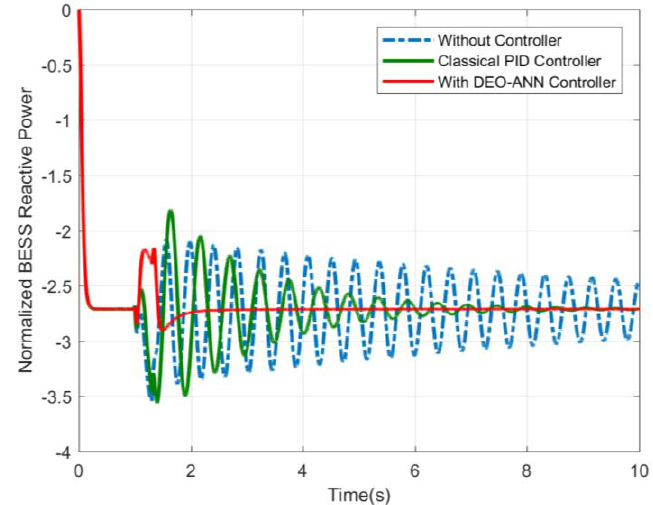
Figure 25 . Injected reactive power by the BESS. Figure 25. Injected reactive power by the